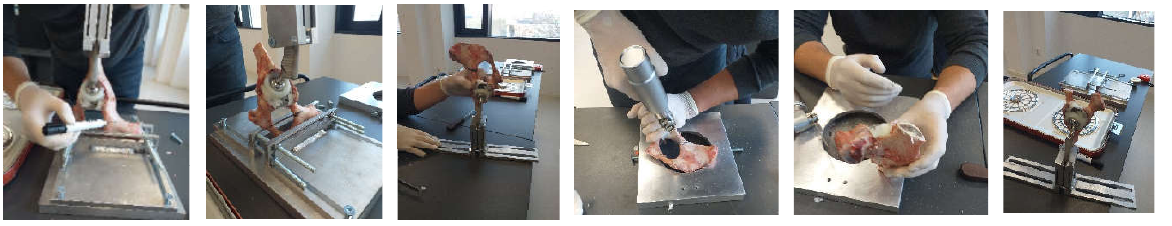
Figure 6. Orthopaedic fitting stages.